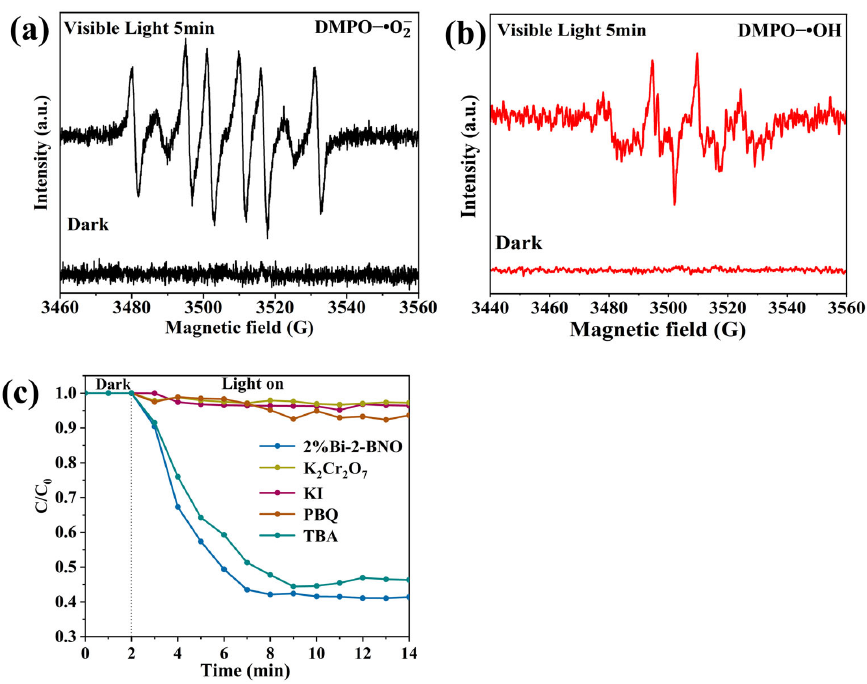
Figure 10. EPR spectra of the ( a ) DMPO − • O (cid:2870)(cid:2879) and ( b ) DMPO − •OH adducts under dark and irradiation; ( c ) effect of different radical scavengers on NO removal using 2%Bi ‐ 2 ‐ BNO.